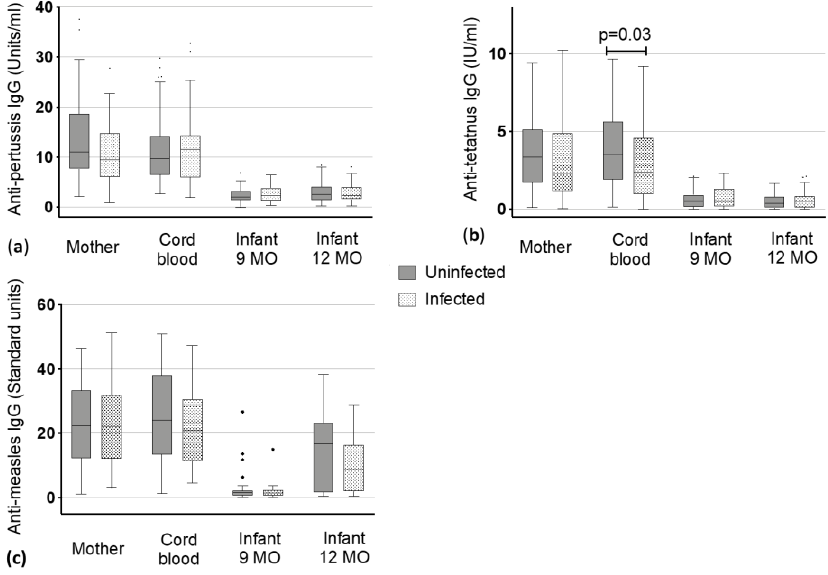
Figure 2. Vaccine-specific immunoglobulin (Ig) G levels to ( a ) pertussis, ( b ) tetanus and ( c ) measles antigens in maternal blood and cord blood at delivery and the infants at 9 and 12 months (MO) of age. Dots represent the outliers not removed by ROUT method.